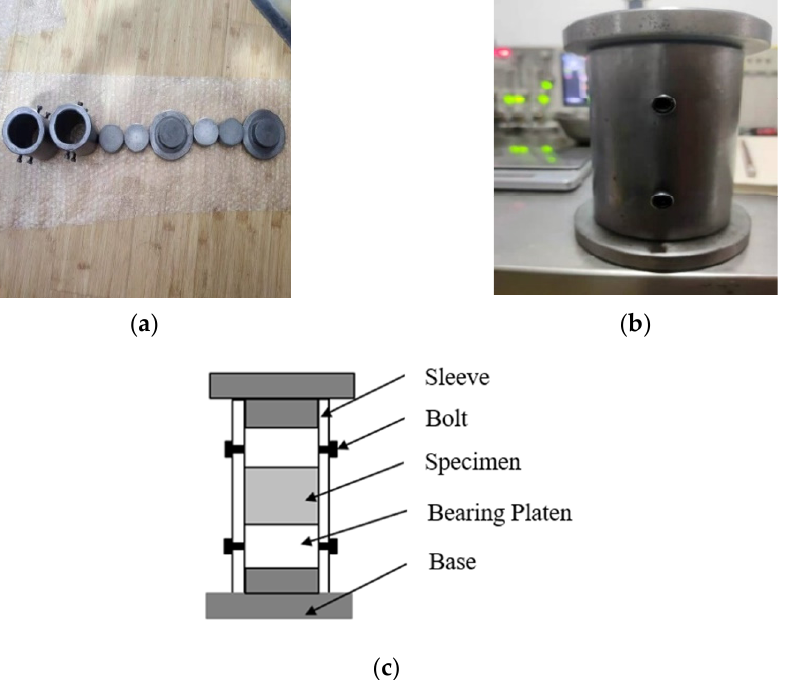
Figure 6. Sleeve, bearing platen and base for specimen fabrication. ( a ) Sleeve, bolts, bearing platens and bases.; ( b ) Assembled steel sleeve; ( c ) Specimen installation diagram.